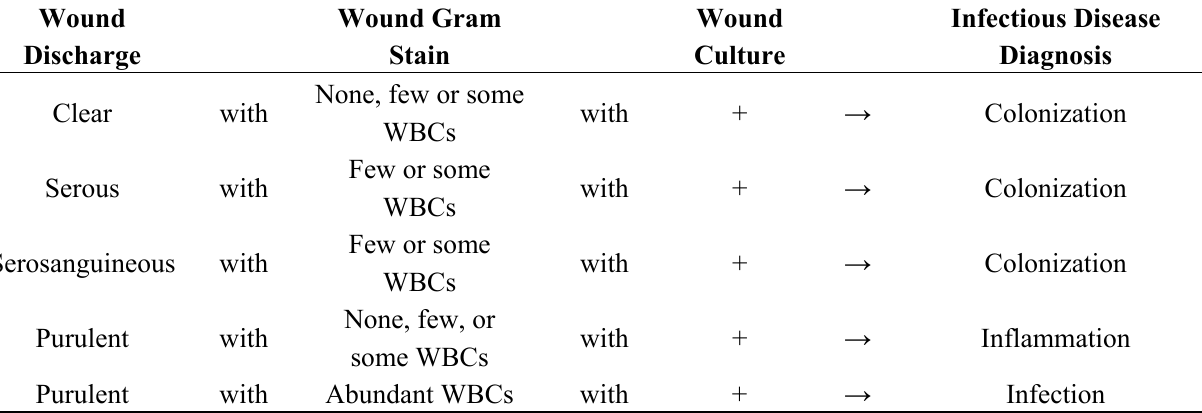
Table 3. Differential diagnostic features of post-operative laminectomy wounds: colonization vs. infection